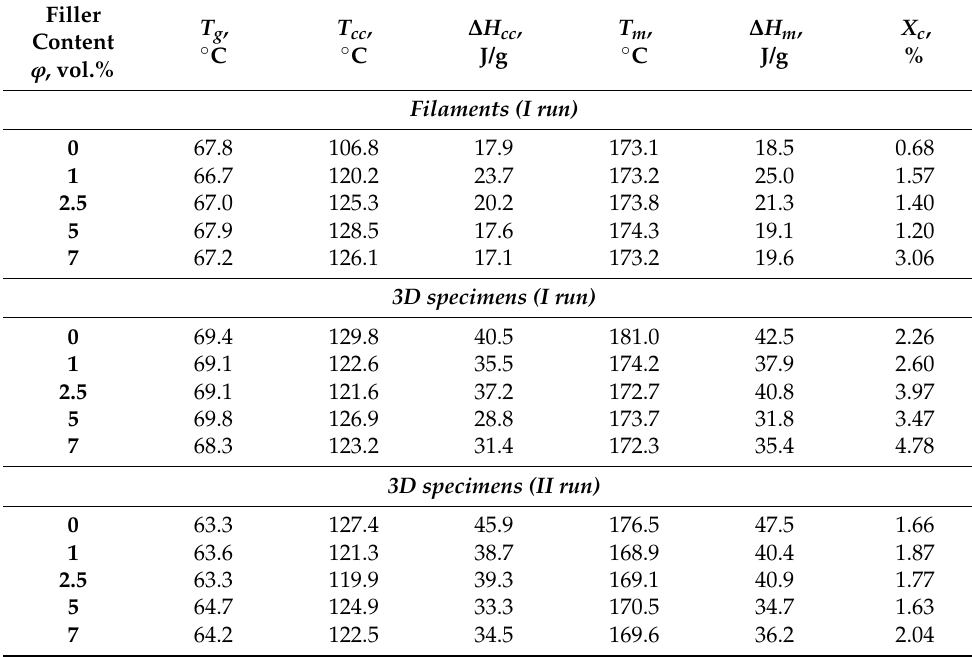
Table 1. Thermal properties of the PLA/CB composites.